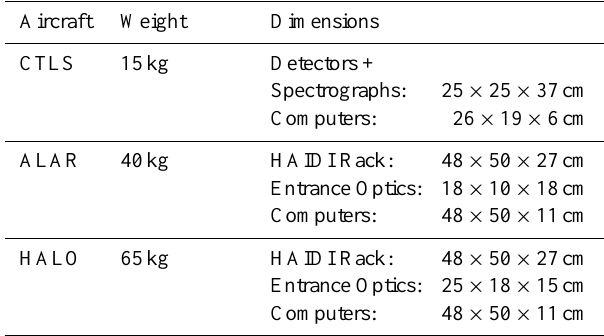
Table 8. Approximate weights and dimensions of the different HAIDI configurations. The first two configurations have an aver- age power consumption of about 100W, while the HALO setup consumes slightly more due to the additional spectrograph-detector